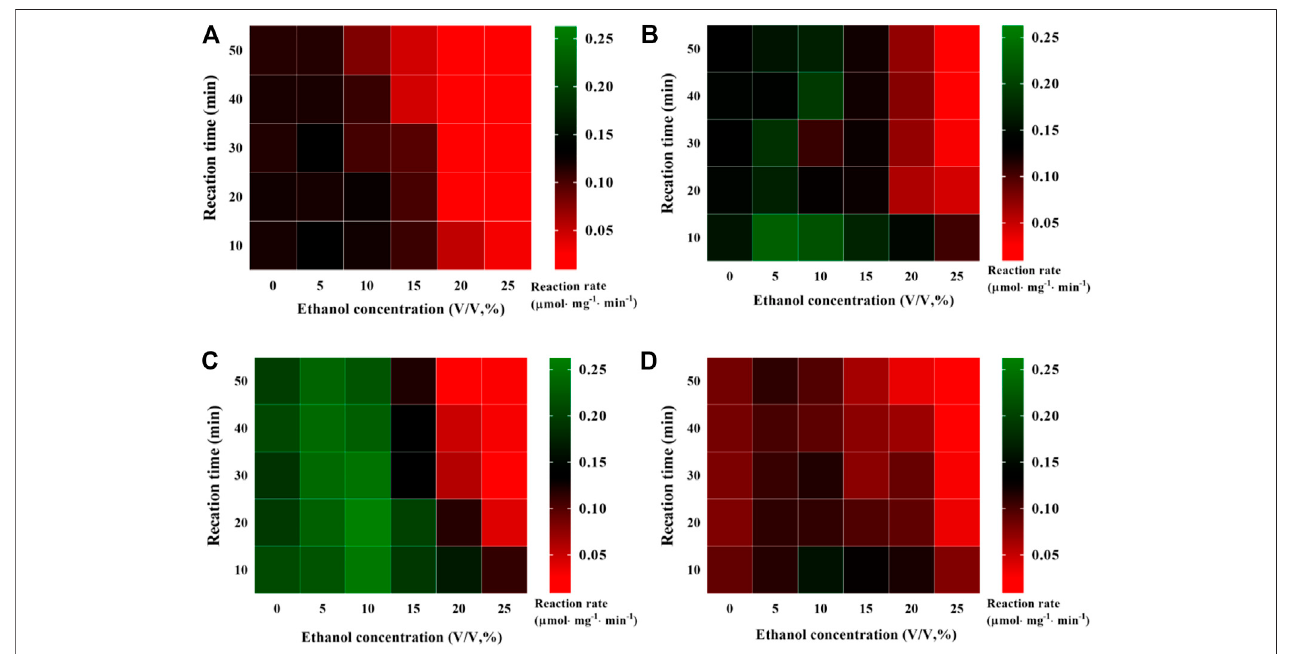
FIGURE5| Evaluationofethanoltolerance.Effectofethanolconcentrationonhydrolysisactivityof (A) freepectinasepreparation, (B) pectinasepreparation@ZSM- 5(27), (C) pectinase preparation@ZSM-5(85), and (D) pectinase preparation@ZSM-5(500).